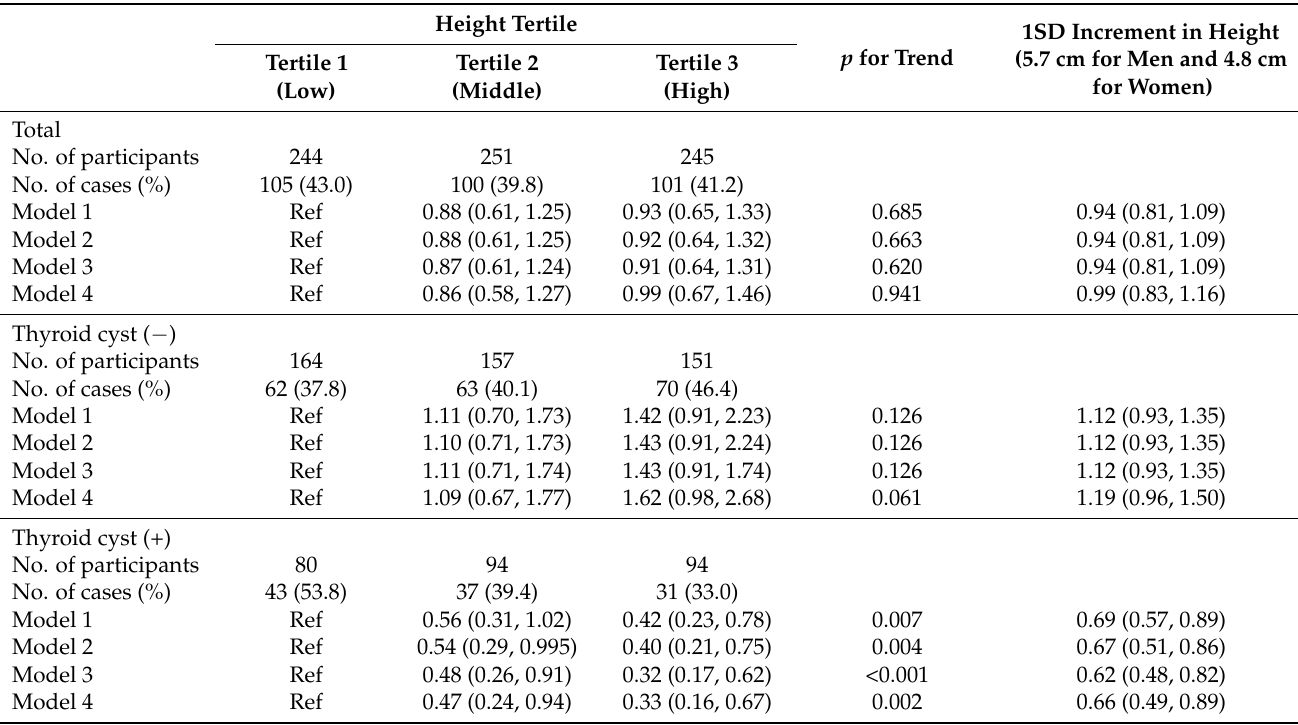
Table 3. Associations between height and active arterial wall thickening among participants overall and stratified by thyroid cyst